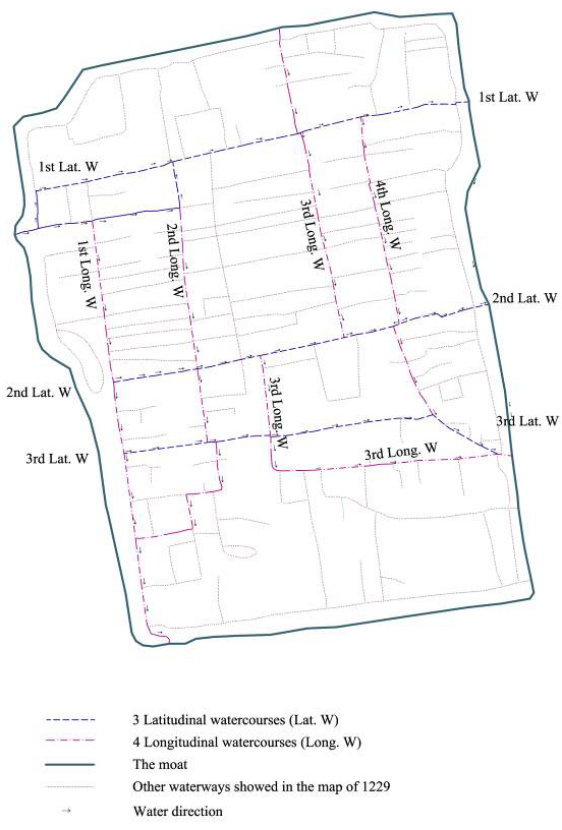
Figure 4 ． 3 Latitudinal and 4 Longitudinal water courses in a BASE